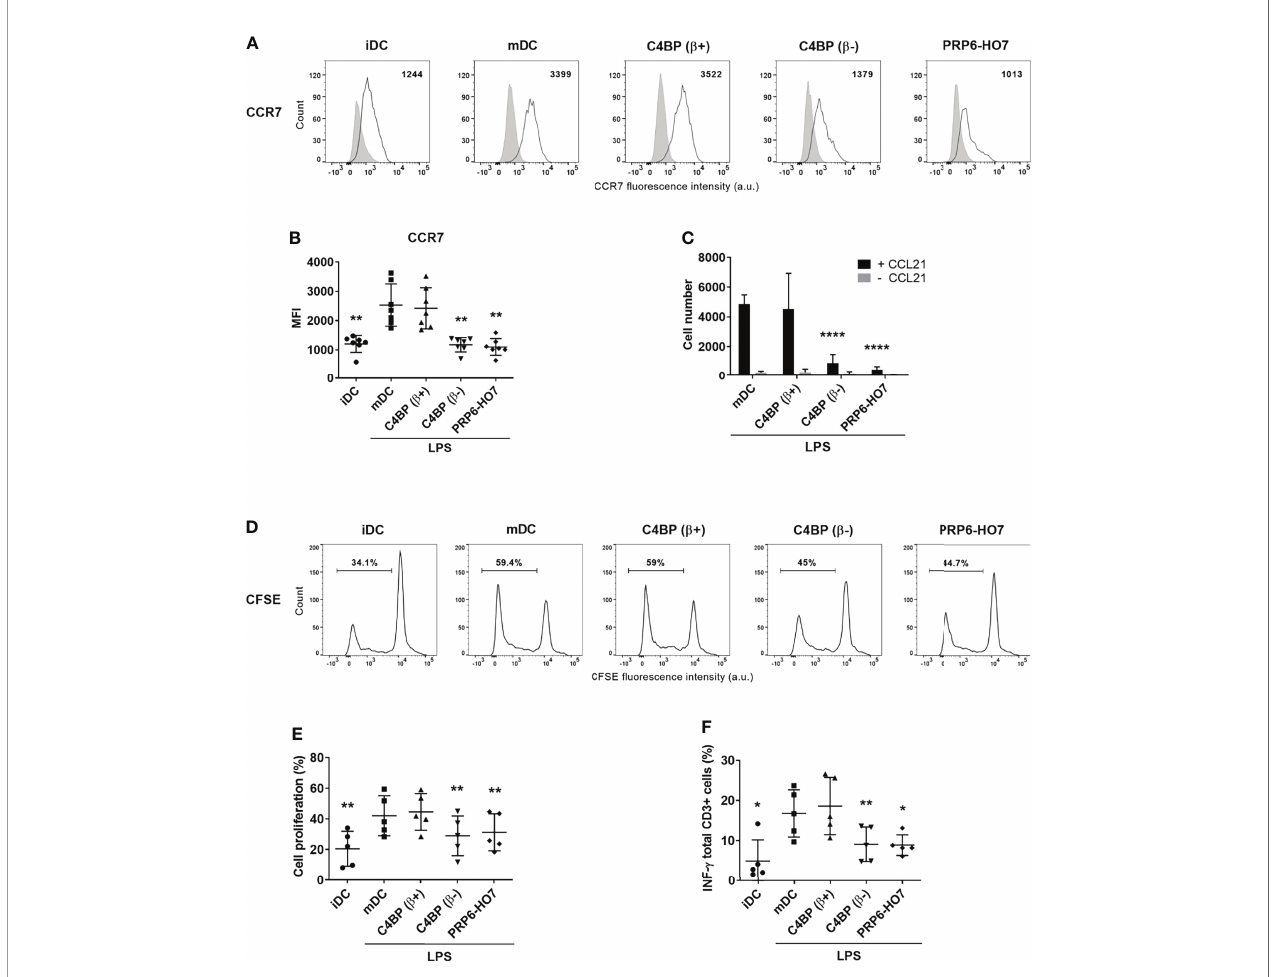
FIGURE 7 | |PRP6-HO7 down-regulates CCR7 expression, alters the chemotaxis, and prevents T cell alloproliferation and IFN- g production in Mo-DCs. CCR7 expression analysis of Mo-DCs at translational level. Representative histograms displaying CCR7 surface expression (A) , and its quanti fi cation (B) on C4BP( b +)- treated, C4BP( b -)-treated (both at 12 nM), and PRP6-HO7-treated (32 nM) and LPS-matured DCs. Isotype control is shown in gray. The MFIs for CCR7 cell surface expression are indicated. Results shown are the mean ± SD from 7 independent donors. (C) Migration of untreated, C4BP( b +)-treated, C4BP( b -)-treated (both at 12 nM), and PRP6-HO7-treated (32 nM) DCs towards the chemokine CCL21 after LPS maturation was assessed in a transwell assay. Shown are the absolute numbers of LPS-matured DCs (mDC) migrated toward the lower CCL21-containing chamber after 2 h incubation (black columns). Spontaneous migration of DCs towards a lower chamber without CCL21 was also assessed (grey columns). Results are the mean ± SD from 7 independent donors performed in duplicate. Allogeneic CD3+ T cells were labeled with the CSFE dye and co-cultured with C4BP( b +)-treated, C4BP( b -)-treated (both at 12 nM), and PRP6-HO7-treated (32 nM) and LPS-matured DCs at 1:5 DC:T cell ratio. (D) Histograms from one representative experiment indicating the percentage of proliferating cells that have lost the CSFE dye. (E) Quanti fi cation of the percentage of T cell proliferation. (F) Percentage IFN- g production by CD3+ T cells. Results shown are the mean ± SD from 5 independent donors. iDC, untreated, immature DCs; mDC, untreated, LPS-matured DCs (*p < 0.05; **p < 0.01; ****p < 0.0001 compared with